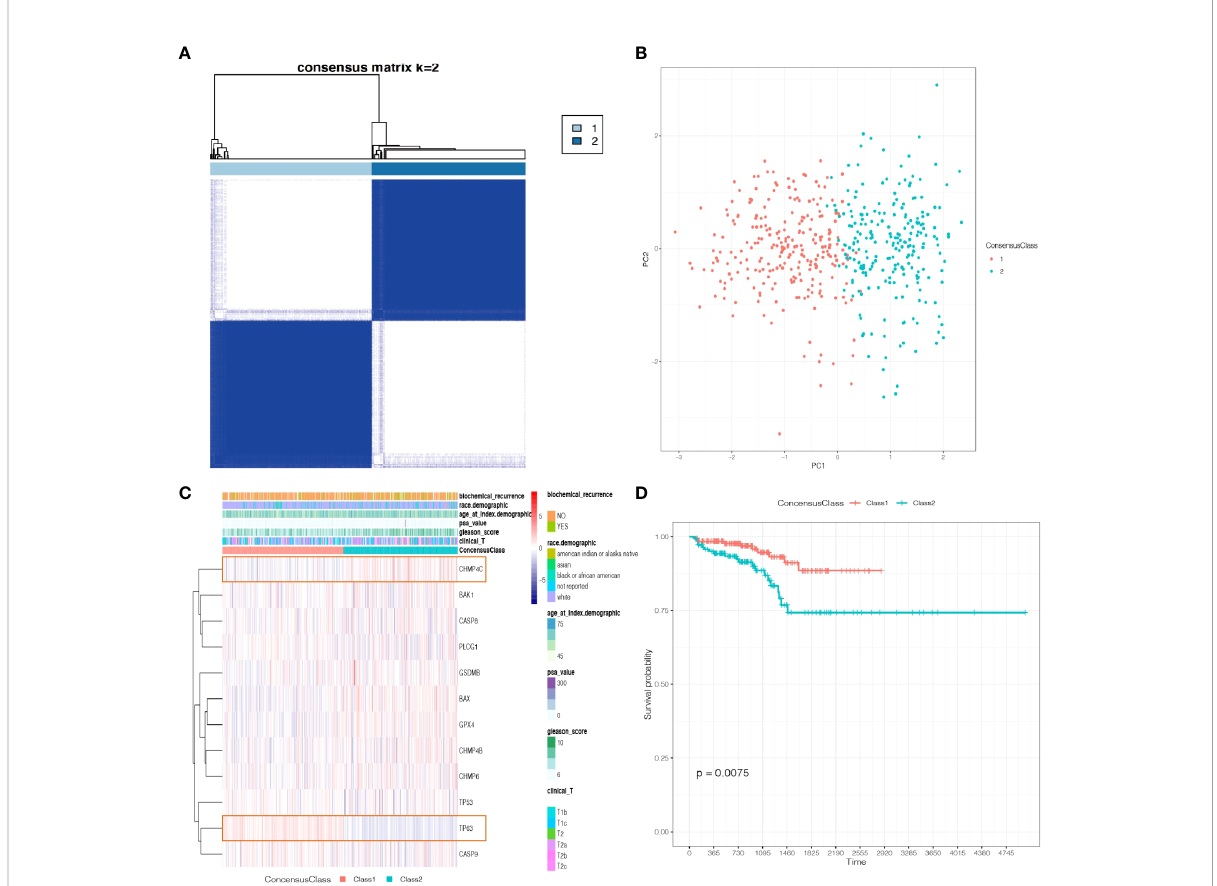
FIGURE 3 Tumor classi fi cation based on the prognostic pyroptosis-related genes. (A) 499 PCa patients were divided into two Classes. (B) PCA plot based on the gene expression of the two Classes. (C) The heatmap and the clinicopathological characteristics of the two Classes. (D) Kaplan-Meier RFS curve of the two